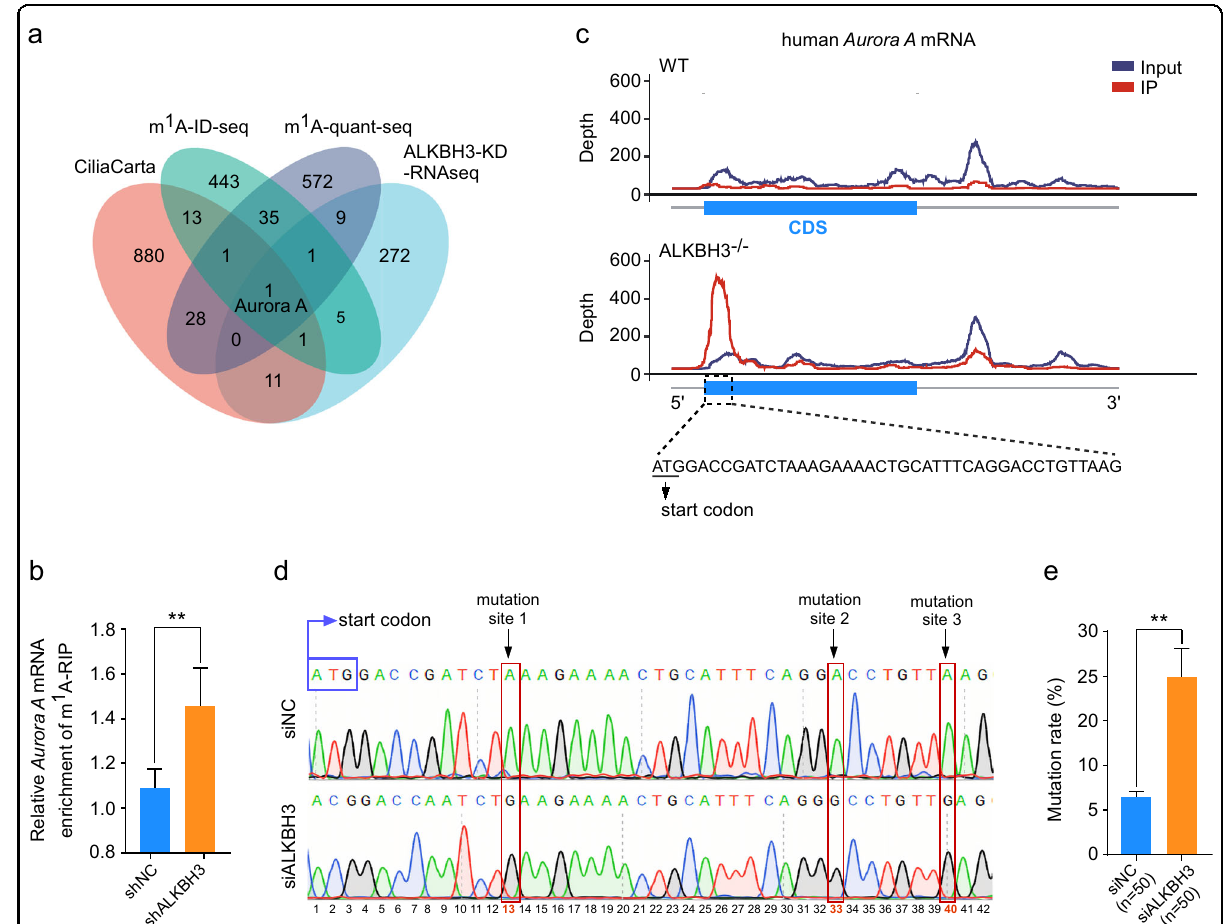
Fig. 2 ALKBH3 removes m 1 A sites on Aurora A mRNA. a Venn diagram showing the overlapped transcripts from the databases of CiliaCarta, m 1 A- ID-seq, m 1 A-quant-seq, and RNA-seq in ALKBH3-KD cells. KD, knockdown. b Cells infected with lentivirus carrying shRNA targeting negative control (NC) or ALKBH3 were subjected to m 1 A RNA immunoprecipitation-qPCR analysis (m 1 A-RIP). m 1 A levels of Aurora A mRNA in control and ALKBH3- depleted cells were measured. c Peak-calling analysis of speci fi c m 1 A peaks of Aurora A mRNA in wild-type and ALKBH3 knockout HEK-293T cells. d Sanger sequencing of Aurora A PCR products ampli fi ed from cDNAs that were reverse-transcripted by RT-1306 in the control and ALKBH3-depleted cells. Mutations at the m 1 A site are highlighted with red box. e Mutation rates at m 1 A sites of Aurora A mRNA in the indicated group are shown. Data are presented as the means ± SD from at least three independent experiments. Student ’ s t -test; ** P <